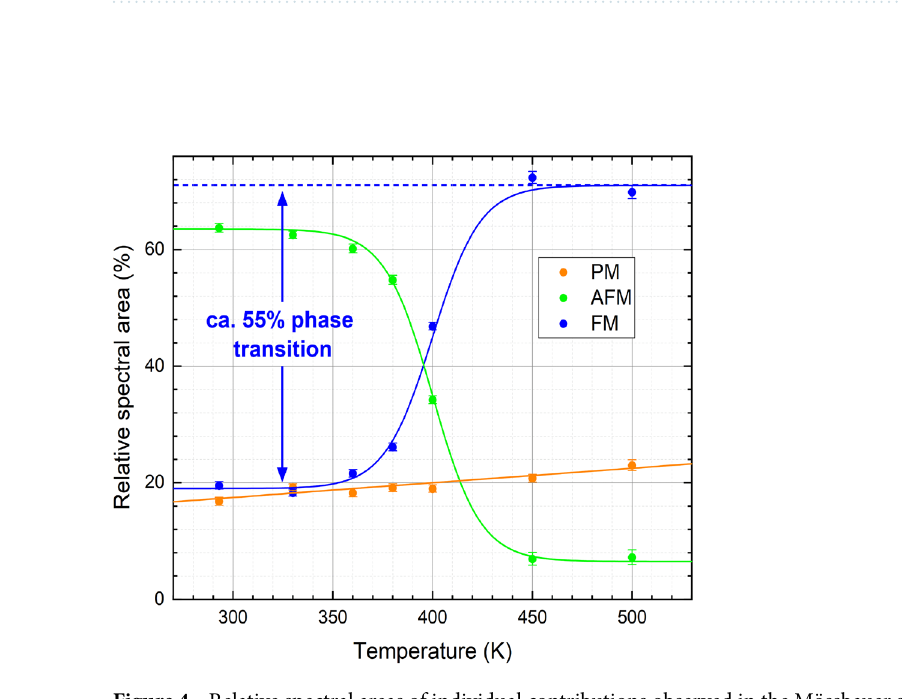
Figure 4. Relative spectral areas of individual contributions observed in the Mössbauer spectra of the annealed FeRh nanoparticles: (super-)paramagnetic doublet (orange), low-temperature AFM-state (green) and high- temperature FM-state (blue). Sigmoidal interpolation curves provide a guide to the eye. After the initial fitting of experimental Mössbauer spectra, hyperfine parameters B HF and isomer shift δ were regulated by their known temperature-dependent behavior to ensure a higher precision in the determination of the shown subspectral